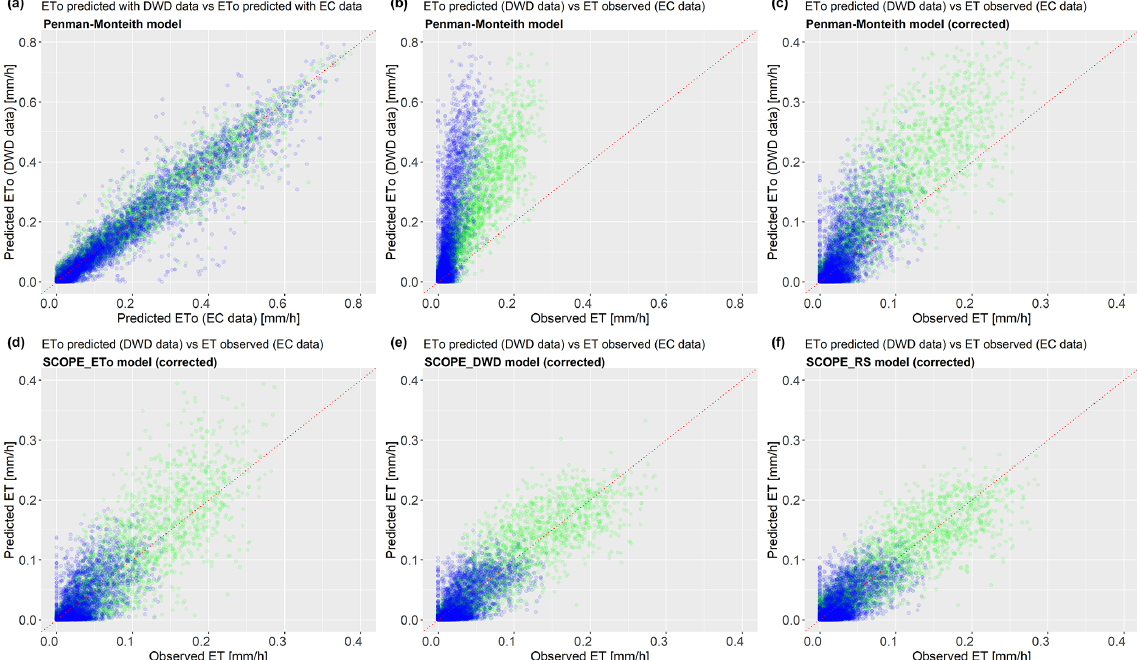
Figure 3. The relationship between ET 0 calculated using data from the meteorological stations and the EC towers (a) , ET 0 from the DWD data versus observed ET from the EC tower (b) , ET 0 (corrected) versus observed ET (c) , corrected SCOPE_ET 0 inputs versus ob- served ET (d) , corrected SCOPE_DWD versus observed ET (e) , and corrected SCOPE_RS versus observed ET (f) . The green dots represent the ROTH site, and the blue dots represent the TUCC site. Table 3. Model accuracy for each scenario according to the metrics RMSE, R 2 and relative bias for ET 0 (Penman-Monteith) and SCOPE, with and without the correction factor for urban environments. The highlighted bold values represent the highest precision and lowest bias based on each metric. Model Input Correction for urban ROTH TUCC approaches scenarios environments RMSE R 2